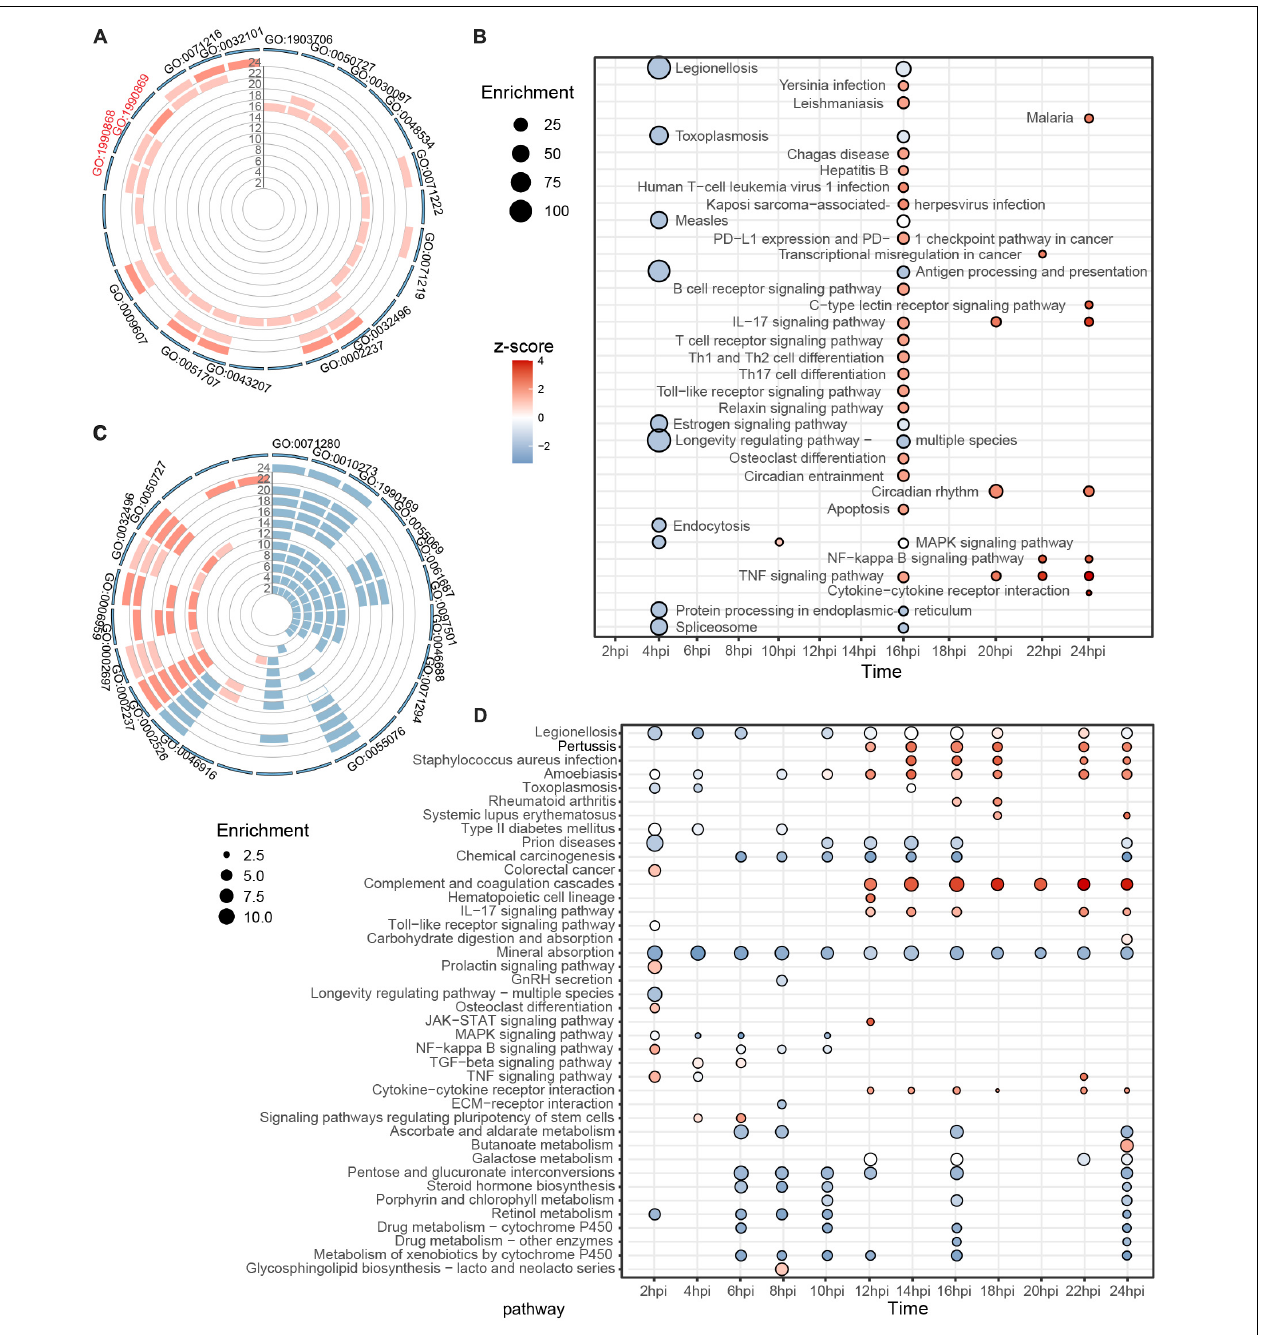
FIGURE 3 | Individual GO and KEGG enrichment analysis based on identified DEGs. (A,B) Dynamic biological processes and pathways in Vero E6 between 2 and 24 hpi, with top 10 terms displayed for each time. (C,D) Similarly, trends in biological processes and pathways in Huh7 during SARS-CoV-2 infection. Color of bar chart or bubble represents z -score (up-/down trend); size of bubble represents enrichment factor. All results meet P < 0.05, sorted by P , and top 10 results from each group are shown. See Supplementary Table 3 for additional